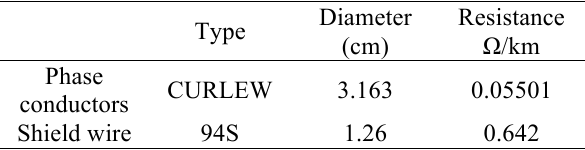
Table 3: Line conductor